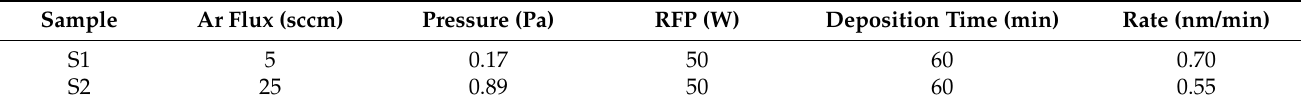
Table 1. Deposition parameters used for the sputtering of the TiO 2